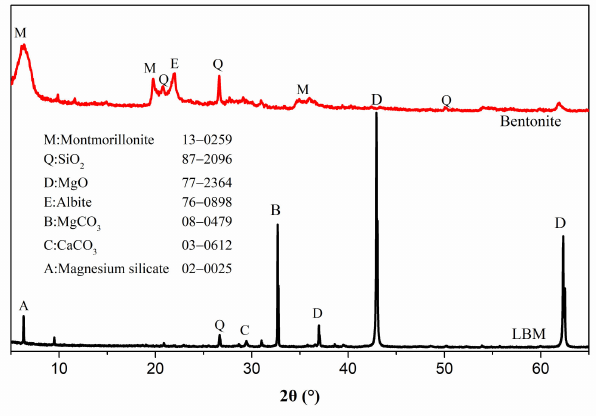
Figure 1. XRD curves of bentonite and LBM.